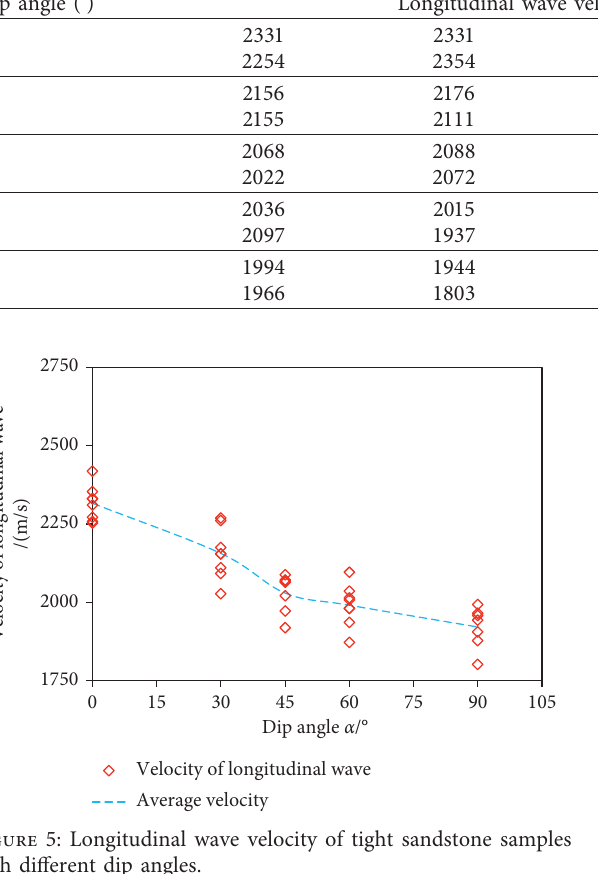
Figure 4: Typical curves of stress-strain of tight sandstone samples with different dip angle under the same confining pressure. (a) Confining pressure σ 3 � 0 MPa. (b) Confining pressure σ 3 � 45MPa. Table 3: Longitudinal wave velocity of tight sandstone samples with different dip angle. Dip angle ( ° )